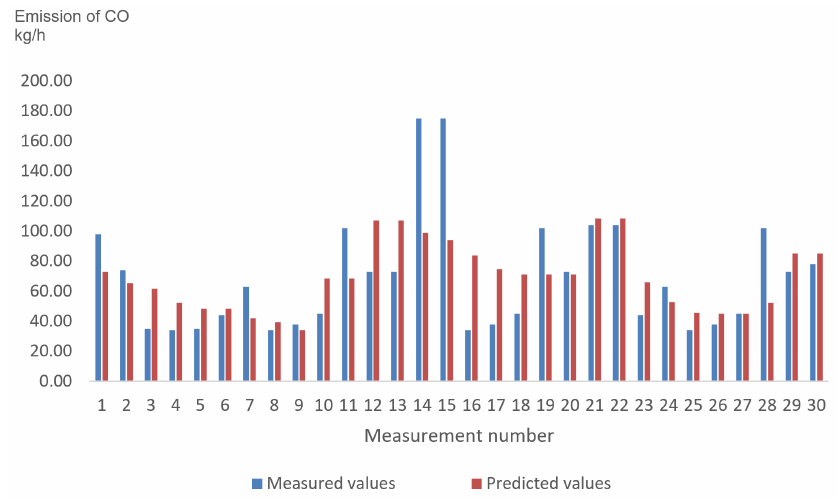
Figure 3. Comparison of the predicted values of the CO emission model with measured values.